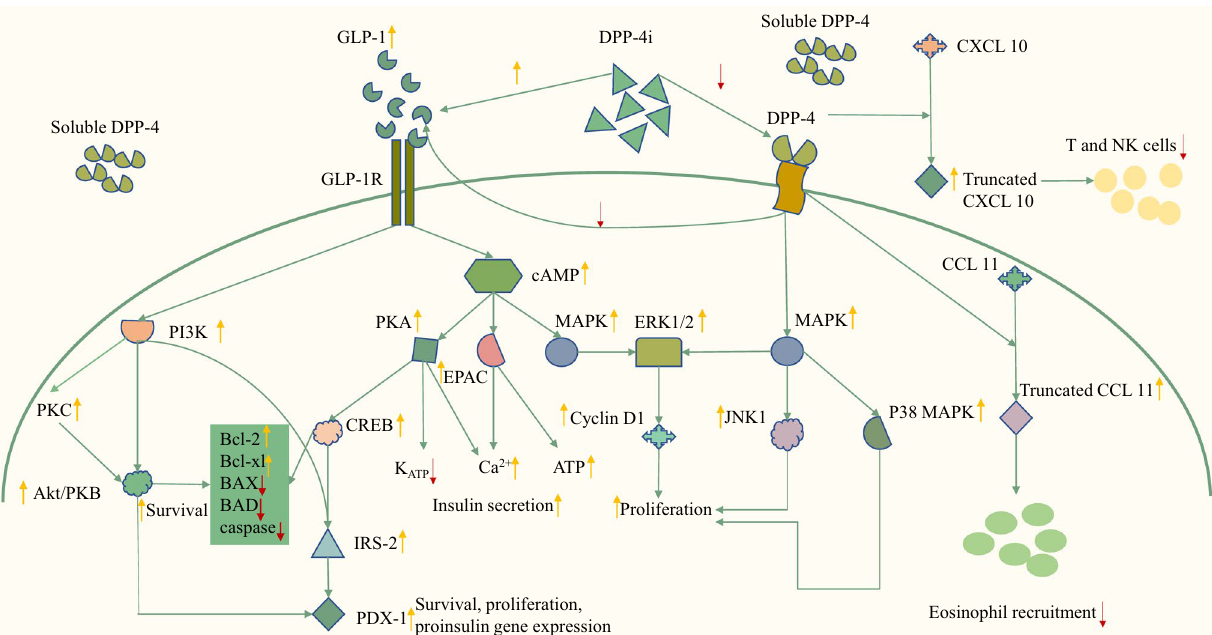
Fig. 3 Signaling pathways of GLP-1 and DPP-4. GLP-1 elicits its incretin effects via an acute elevation in cAMP levels and subsequent acti- vation of PKA and EPAC when binding to GLP-1 receptors on beta-cells. GLP-1 slows the progressive loss of beta-cell function by the acti- vation of pro-survival CREB signaling. This figure shows two of the common ways by which DPP-4 promotes cancer progression: truncat- ing CCL11 to decrease the migration of eosinophils and CXCL10 to inhibit the migration of T and NK cells. GLP-1 glucagon-like peptide-1, DPP-4 dipeptidyl peptidase-4, cAMP cyclic adenosine monophosphate, PKA protein kinase A, PKC Protein kinase C, Akt/PKB Protein kinase B, EPAC exchange protein directly activated by cAMP, CREB cAMP-response element binding protein, NK natural killer cells, DPP-4i dipeptidyl peptidase-4 inhibitors, MAPK mitogen-activated protein kinase, PI3K phosphatidylinositol-3-kinase, mTOR mammalian target of rapamycin, JNK c-Jun N-terminal kinase, ERK1/2 extracellular signal-regulated kinase 1/2, ATP adenosine triphosphate, IRS insulin receptor substrates, PDX-1 pancreatic and duodenal homeobox 1, CCL C-C motif chemokine ligand, CXCL chemokine (C-X-C motif)